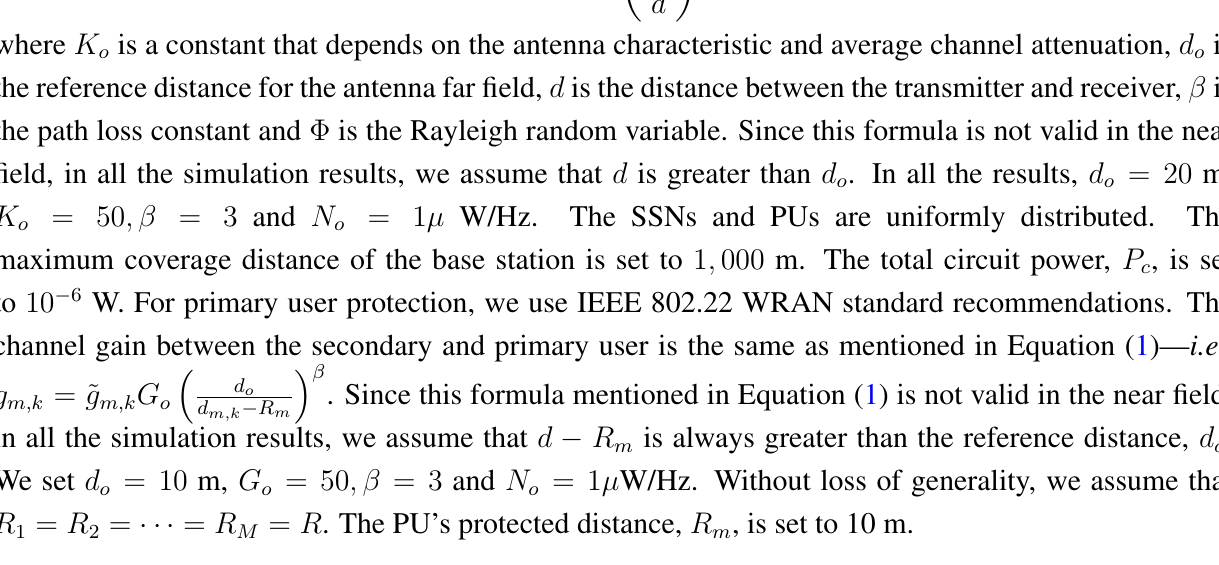
Figure 4. Performance of the iterative algorithm with the number of SSNs, K = { 2,4 }